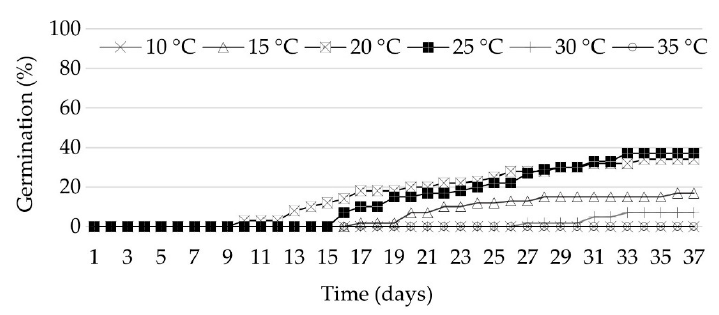
Figure 2. Sideritis raeseri subsp . attica seeds’ germination in Petri dishes containing half-strength Murashige and Skoog media (MS) at 20.0 °C under 16.0 h light/8.0 h darkness: ( A ) after 9.0 days and